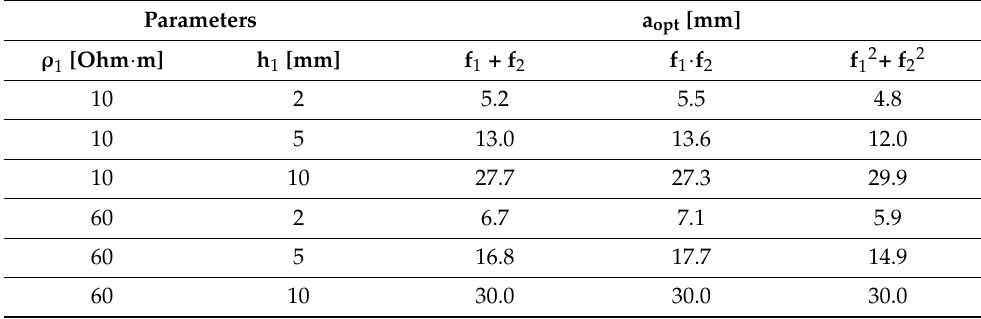
Table 3. Acceptable ES sizes for multiobjective